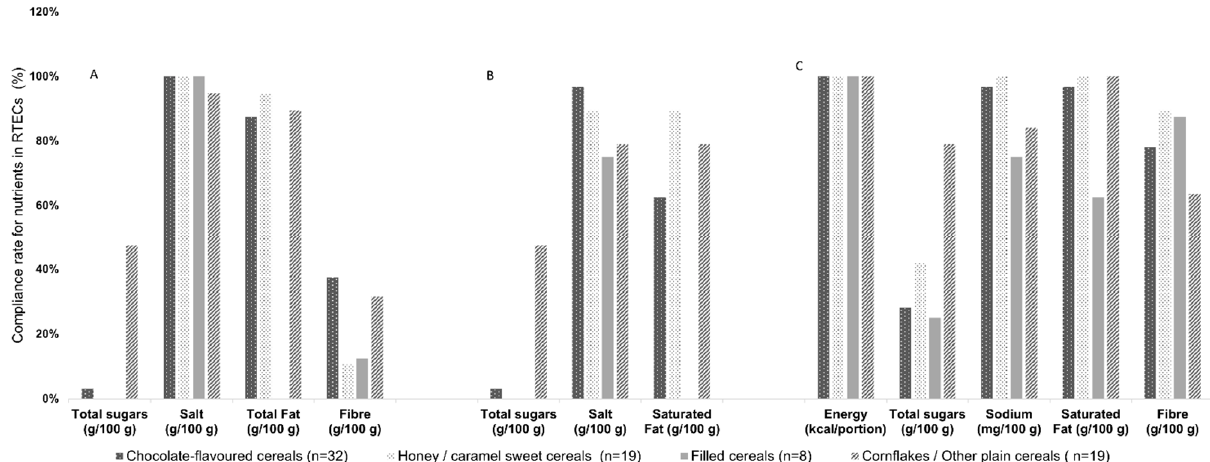
Figure 2. Percentage of agreement between RTECs’ nutrient content and the criteria set by the nutrient profile models: ( A ) the WHO-EURO model, ( B ) the Directorate-General of Health model (NPM-PT), and ( C ) the European Commission (EU-Pledge) model.